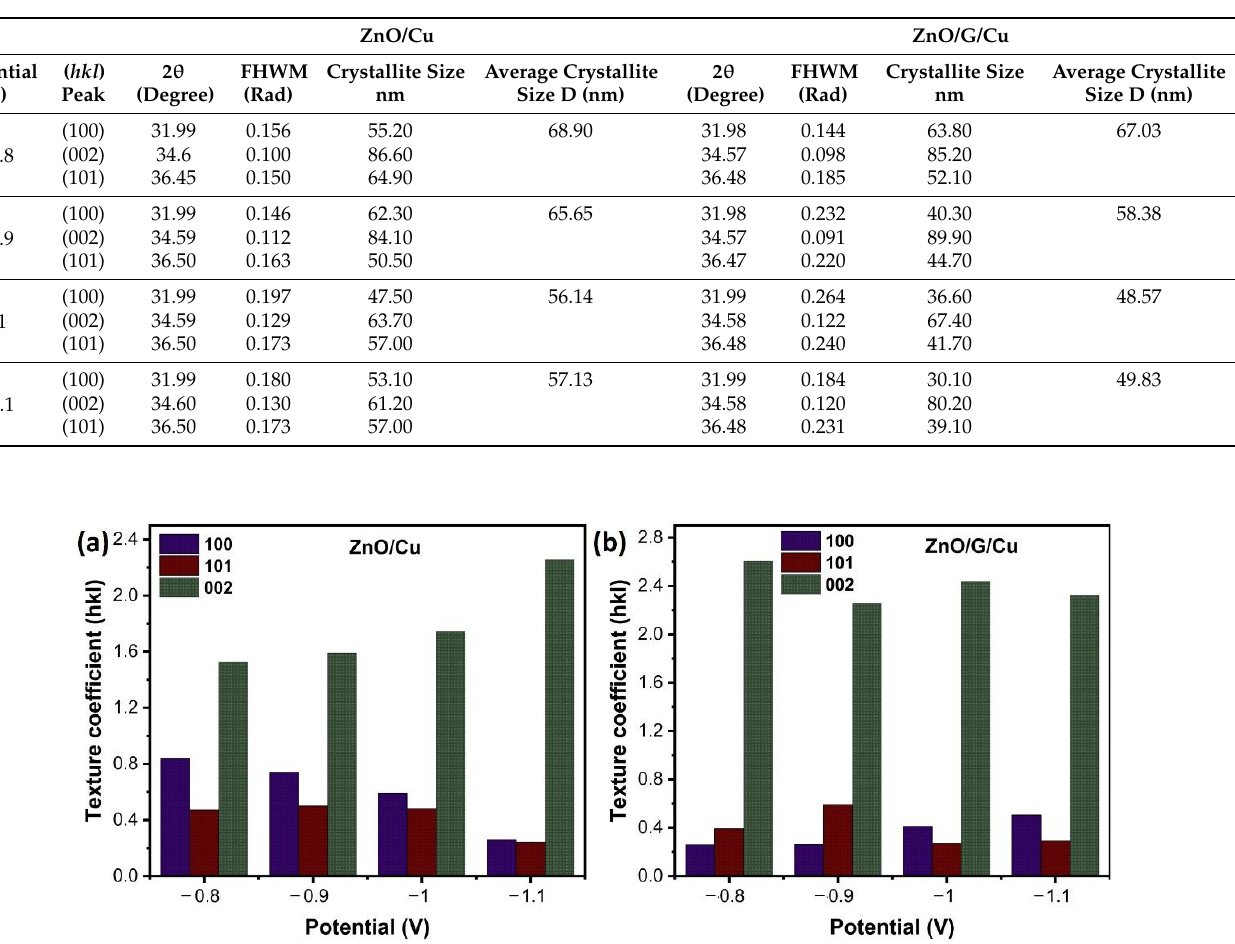
Table 1. Values of 2 θ , FHWM, crystallite size, and average crystallite size D of ZnO/Cu and ZnO/G/Cu at different applied potentials.